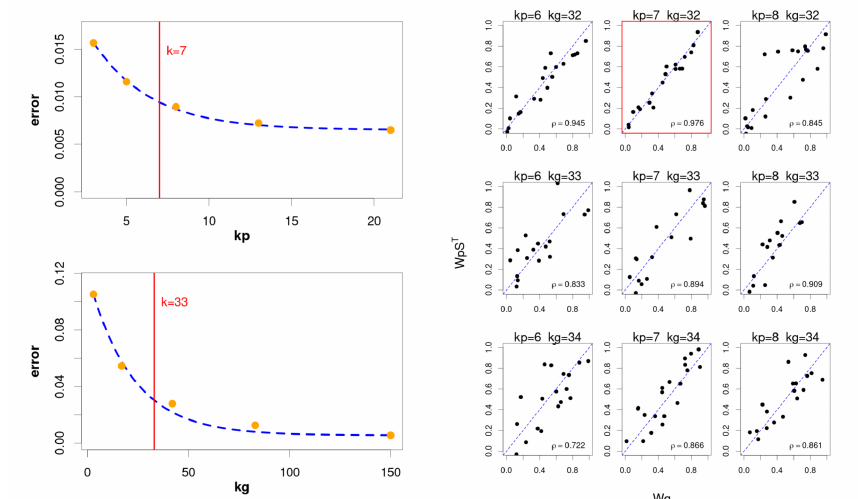
Figure 2. Illustrative example to describe the designed protocol to estimate the optimal number of components ( k g and k p ). On the left, we see the result obtained after fitting the error curve (dashed blue lines) from 5 independent factorisations (orange dots) performed for pathways (top) and genes (bottom), respectively. The result of this process defines the values k p = 7 and k g = 33 as potential “elbow points". From these two values we define the intervals K p = [ 6,7,8 ] and K g = [ 32,33,34 ] to be explored by the hierarchical model, giving a total of 9 joint factorisations to be performed. On the right, we show the scatter plots comparing the values of the gene-level components ( W g ) and their associated pathway-level components ( W p S t ) for the 9 joint factorisations performed by the hierarchical model. The graphs show that the pair of values k p = 7 and k g = 32 provides the best correlation between the components obtained at both levels, being therefore the pair of values to be used for subsequent